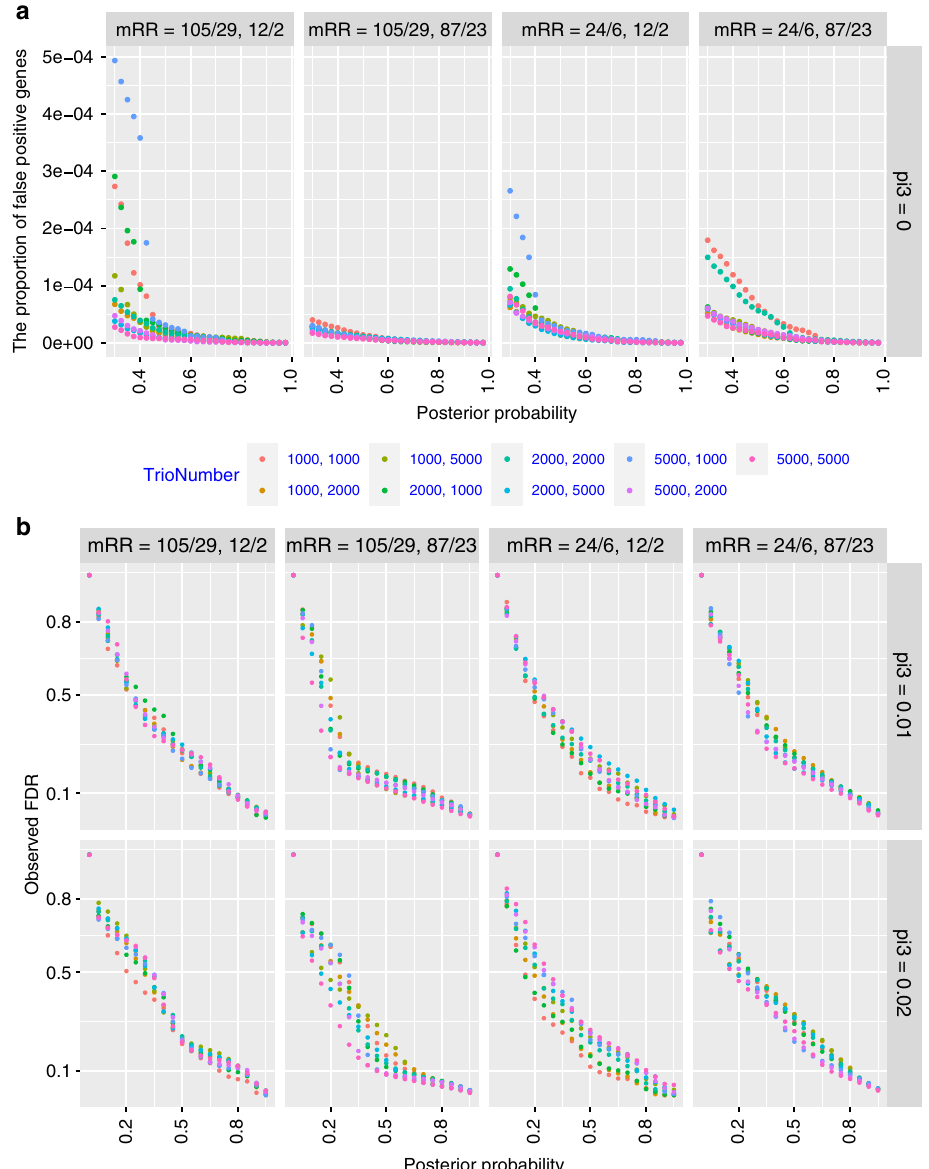
Fig. 3 Validation of shared risk gene identi fi cation using mTADA on simulated data. a The proportion of false positive genes (per 19,358 analyzed genes): X -axes are posterior probabilities of Model III while Y -axes are the proportions of false positive shared risk genes. b The correlation between posterior probabilities ( x -axis) and observed false discovery rates (FDRs, y -axis). These are for the combination of different sample sizes (ntrio) and mean relative risks